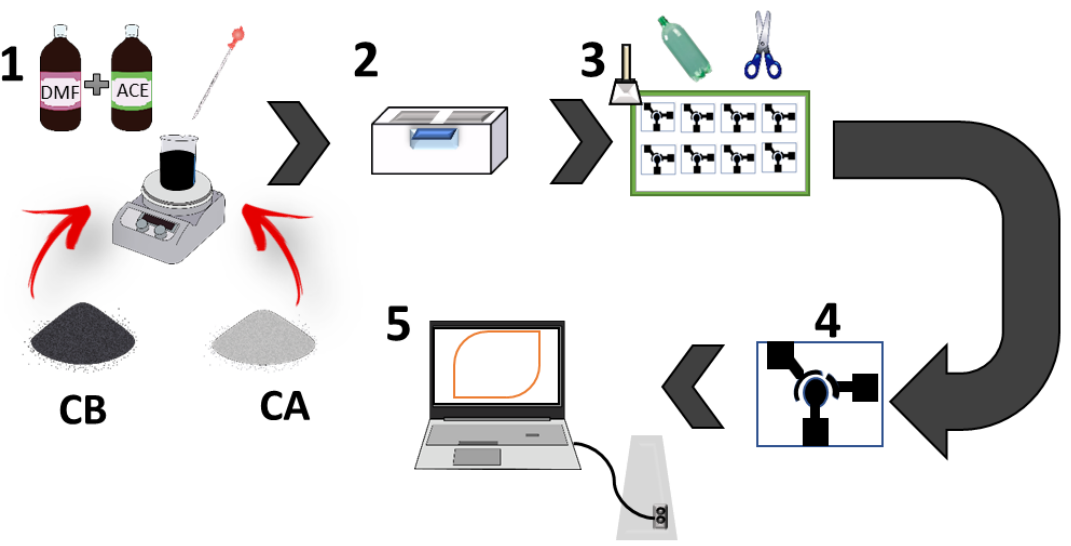
Figure 1. Experimental procedure representation: (1) elaboration of the CB and CA base dispersions; (2) ink preparation; (3) electrode assembly with screen printing technique over PET substrates; (4) finalized capacitor electrode ready for (5) electrochemical